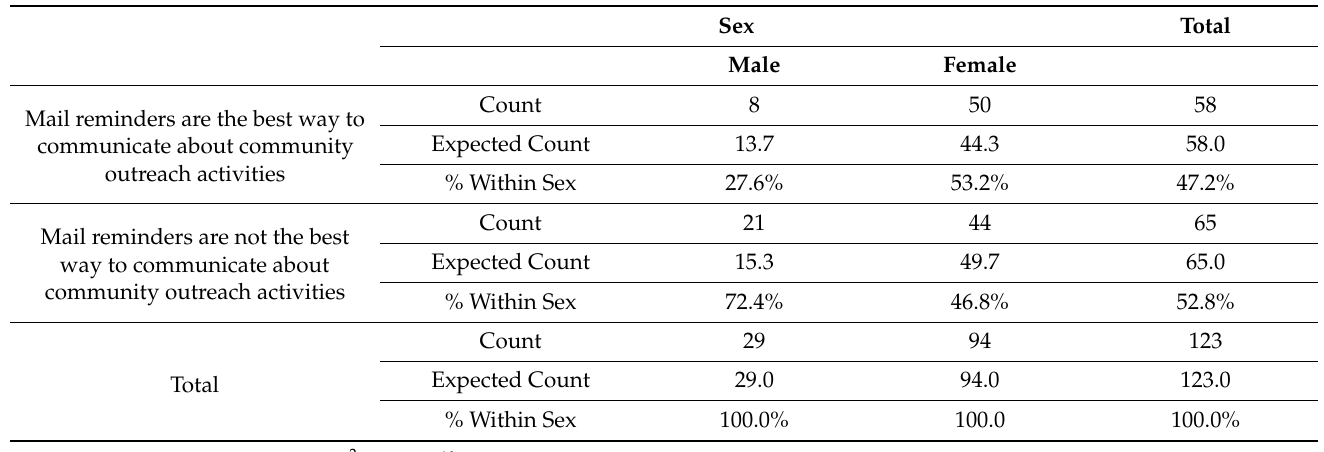
Table 13. Mail Reminders as the Best Way to Communicate to Respondents about Community Outreach Activities by Sex.